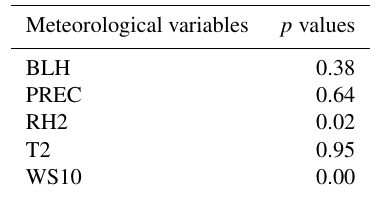
Table 1. The p values for the stepwise linear regression model for